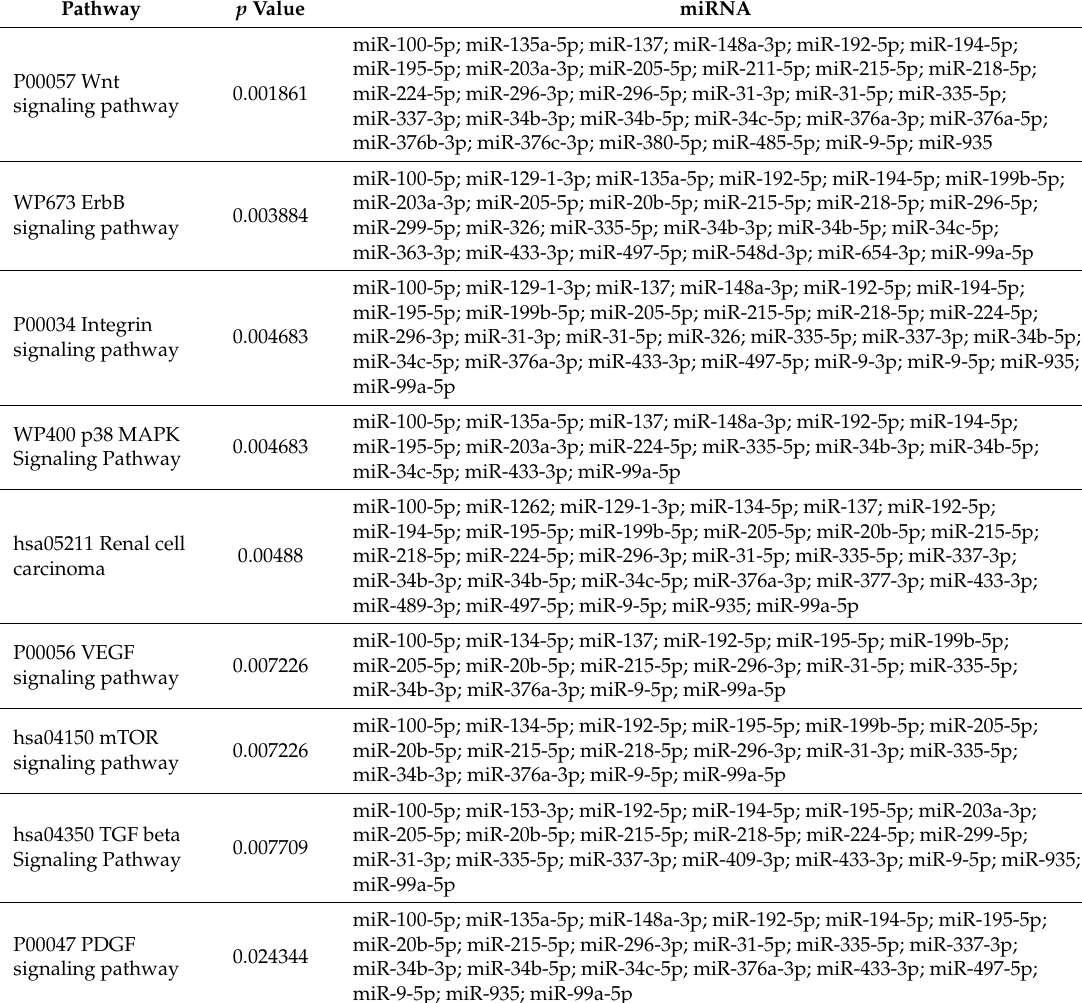
Table 1. The identified miRNA-involved signaling pathways in both bioinformatic analysis 1